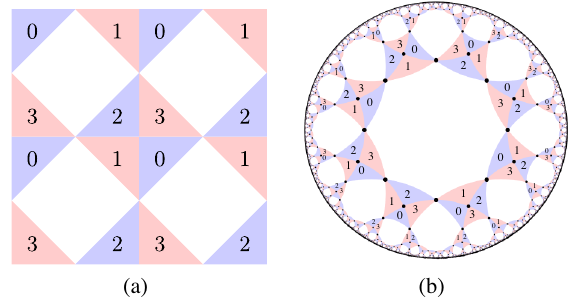
FIG. 6. (a) An L ¼ 2 subsystem surface code. The four types of triangle operators are labeled as 0, 1, 2, and 3. (b) Labeling of the four types of triangle operators on an f 8 ; 4 g tessellation of the hyperbolic plane. The neighborhood of each triangle operator (the types and relative locations of triangle operators it overlaps with) is the same as in the toric